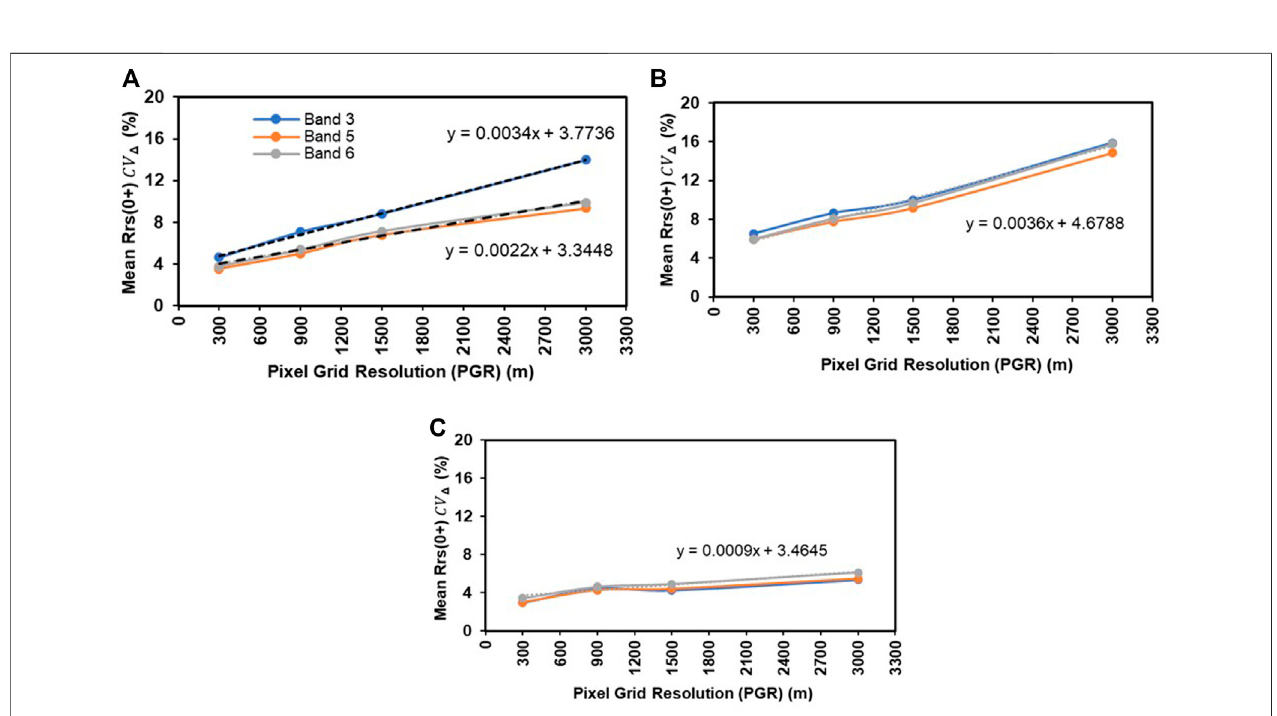
FIGURE8 | Mean R rs (0+)CV Δ versuspixelgrid resolution from 300 to3000 mfor, (A) oceanic, (B) estuarine, and (C) plumewaters for Band 3 (442.5 nm), Band 5 (510 nm), and Band 6 (560 nm) of the Sentinel 3a, OLCI sensor.